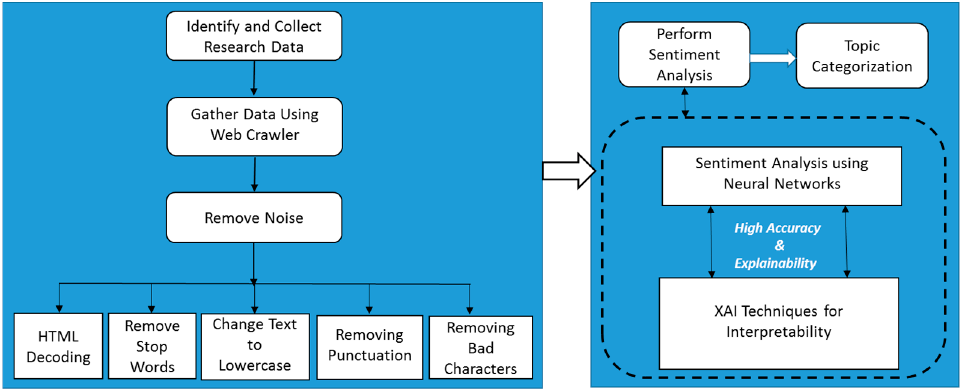
Figure 2. Proposed diagram for future work with high accuracy and explainability.